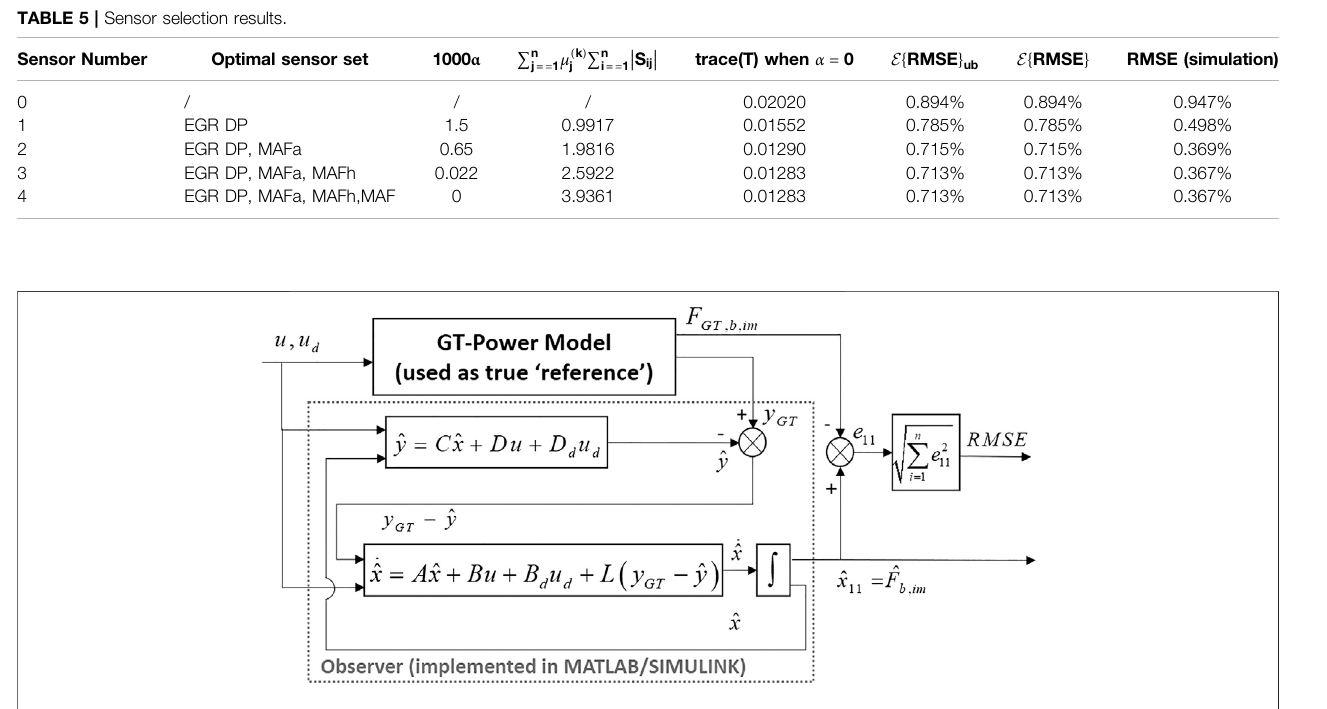
FIGURE 8 | Diagram of GT-Power and observer simulation